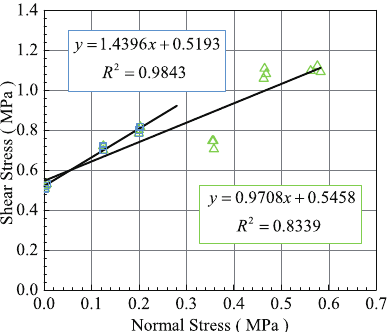
Figure 13. Normal stress dependency of shear stress.